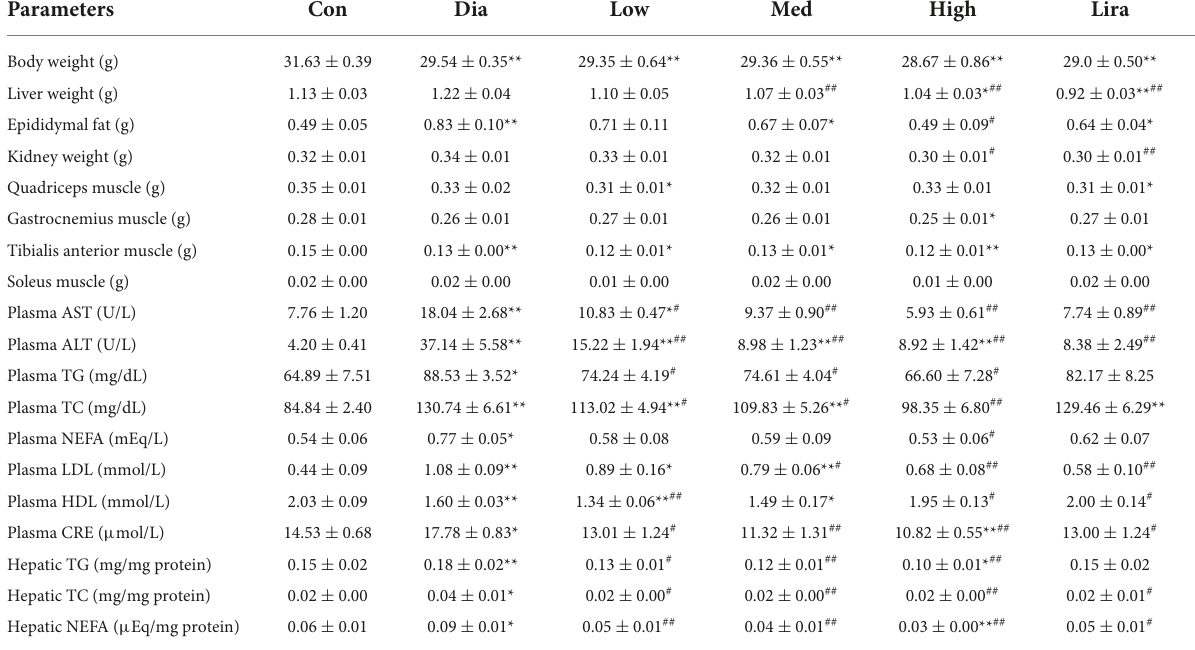
TABLE 1 Effects of CFP on metabolic parameters of type 2 diabetes